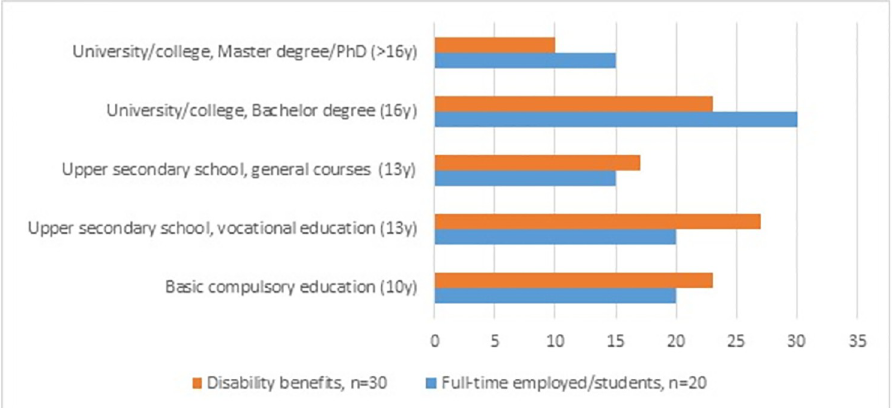
Fig 3. Distribution (%) of educational level according to employment